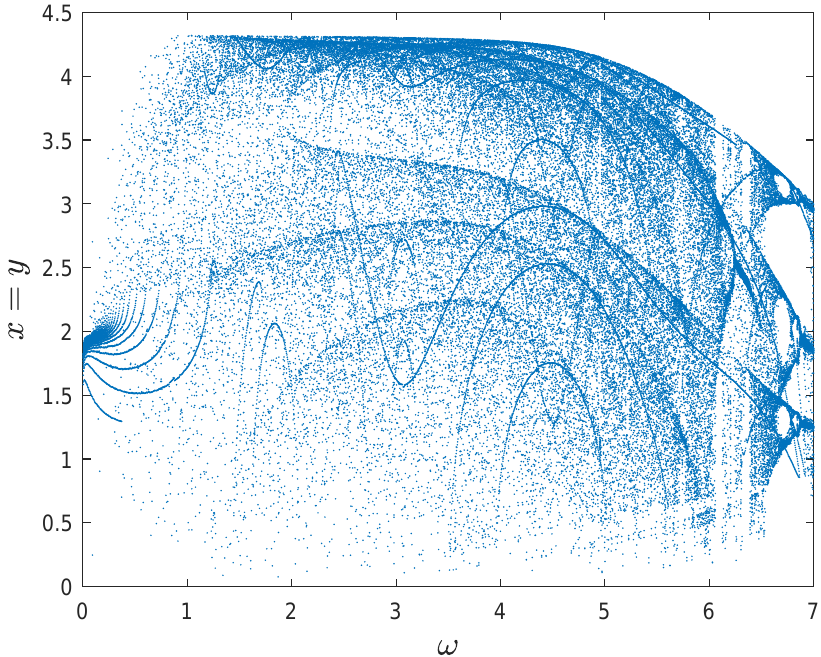
Figure 6. Bifurcation diagrams with respect to parameter ω of Poincare cross-section when x = y .